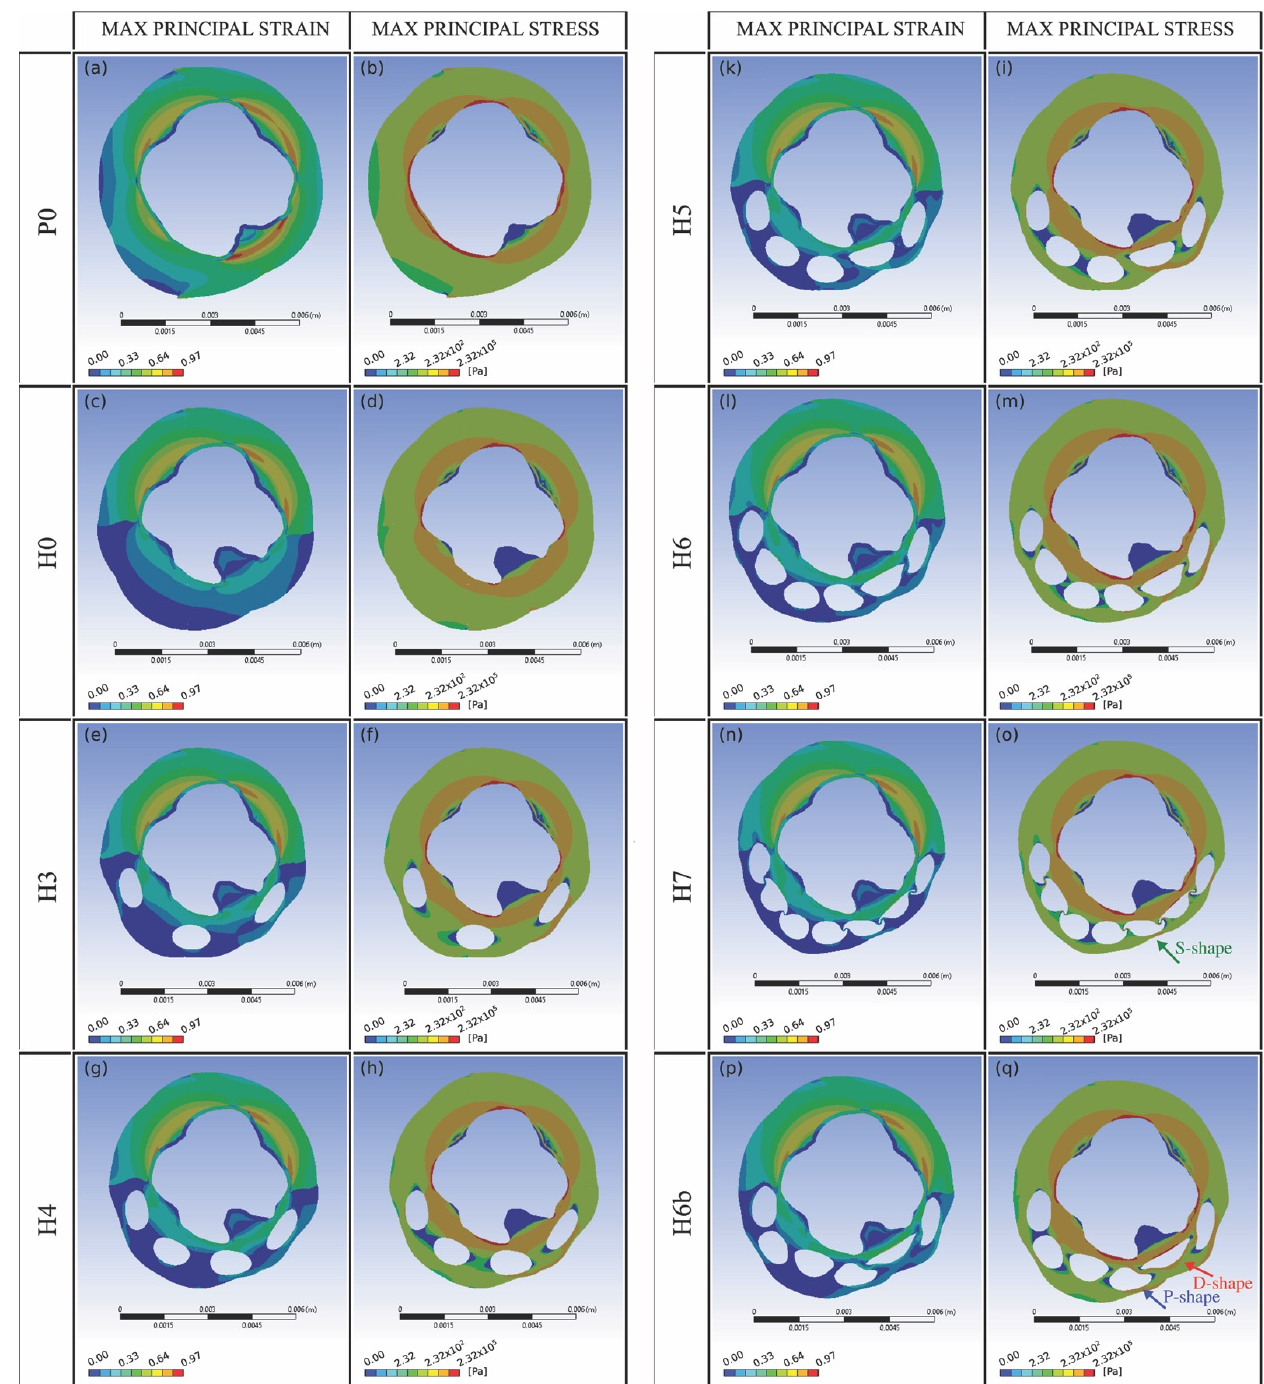
Figure 5. Deformed configurations: maximum principal strain in linear scale ( left panel : subfigures ( a , c , e , h , k , l , n , p )) and maximum principal stress in logarithmic scale ( right panel : subfigures ( b , d , f , g , i , m , o , q )).